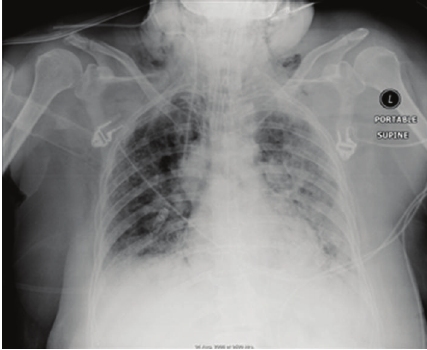
Figure 7: A CXR showing a pneumothorax following insertion of an intravenous line via the right jugular vein. Note the surgical emphysema in the